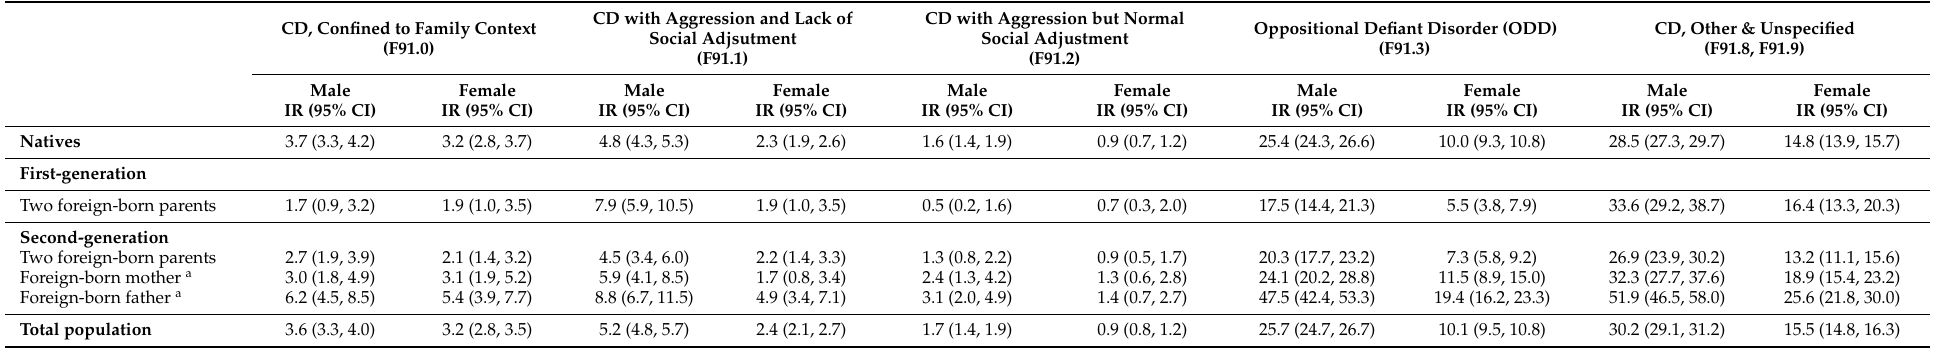
Table A1. Non-adjusted incidence rates of subtypes of conduct disorder per 100,000 participants 4–16 years at baseline in Sweden, 2001–2015. CD, Confined to Family Context (F91.0)